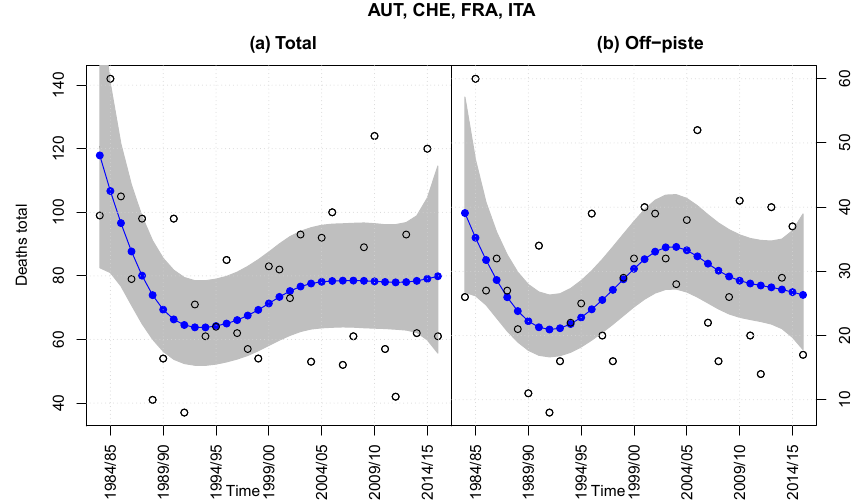
) annual avalanche fatalities – off-piste and backcountry, i.e., total (a) , and off-piste (b) – with 90% Figure 7. Observed ( ◦ ) and estimated ( • confidence bands (grey) in AUT, CHE, FRA and ITA (summing-up) within 1983/1984–2015/2016.